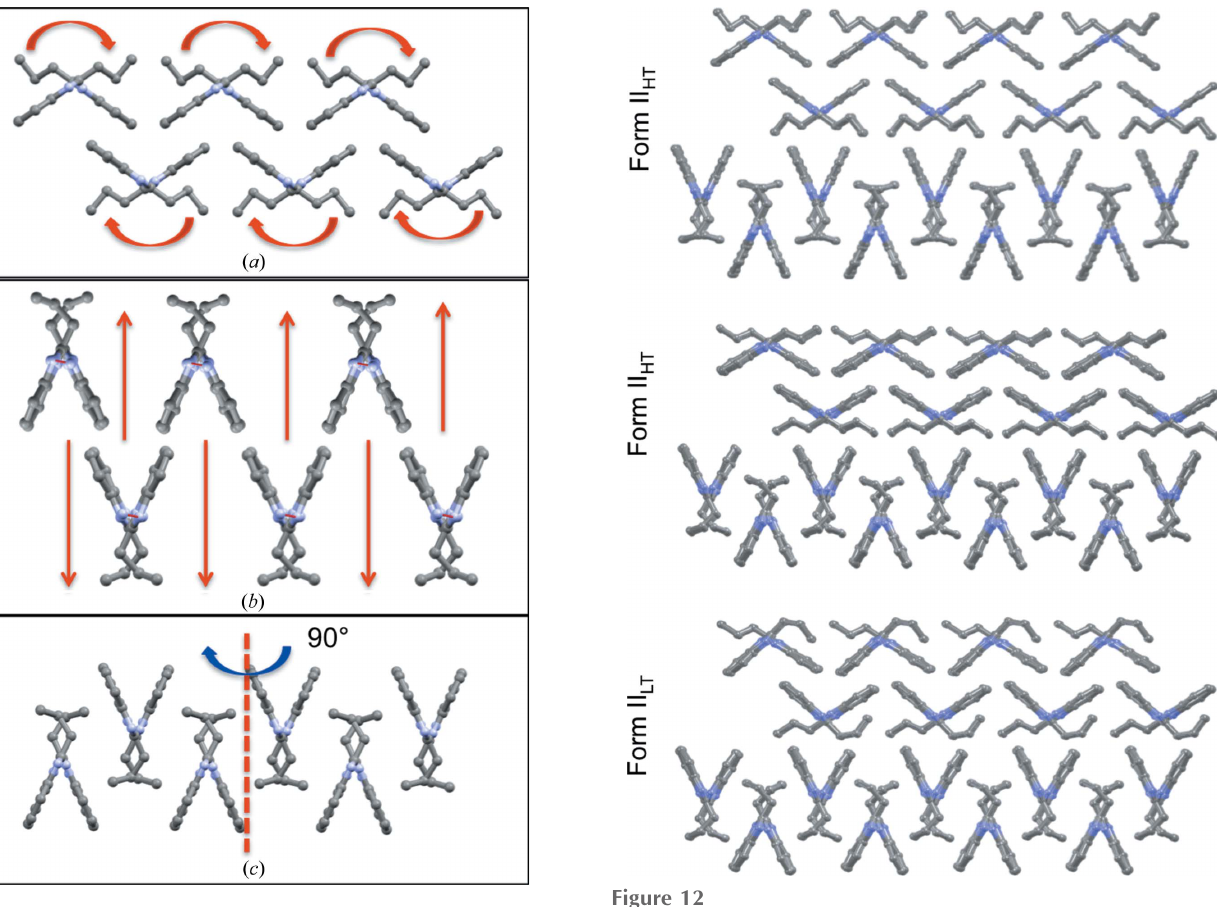
Figure 11 Steps required to convert an A 90 layer into a B